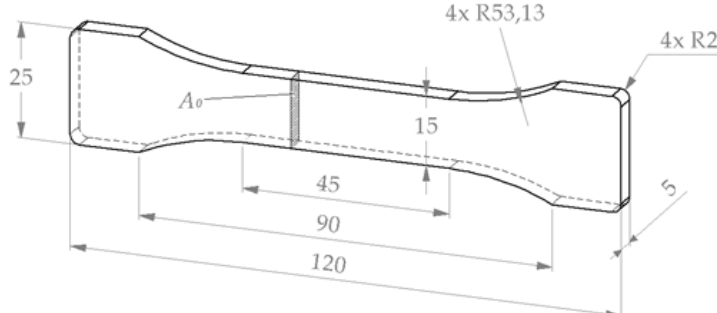
Figure 1. 3D-drawing of a dogbone-shaped specimen. Dimensions are in mm.